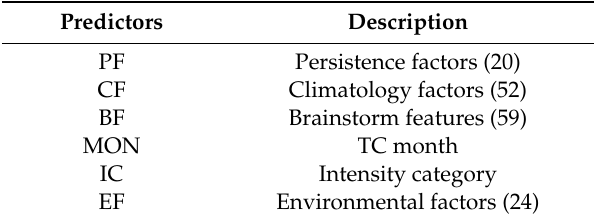
Table 6. Potential climatology, persistence, and environmental